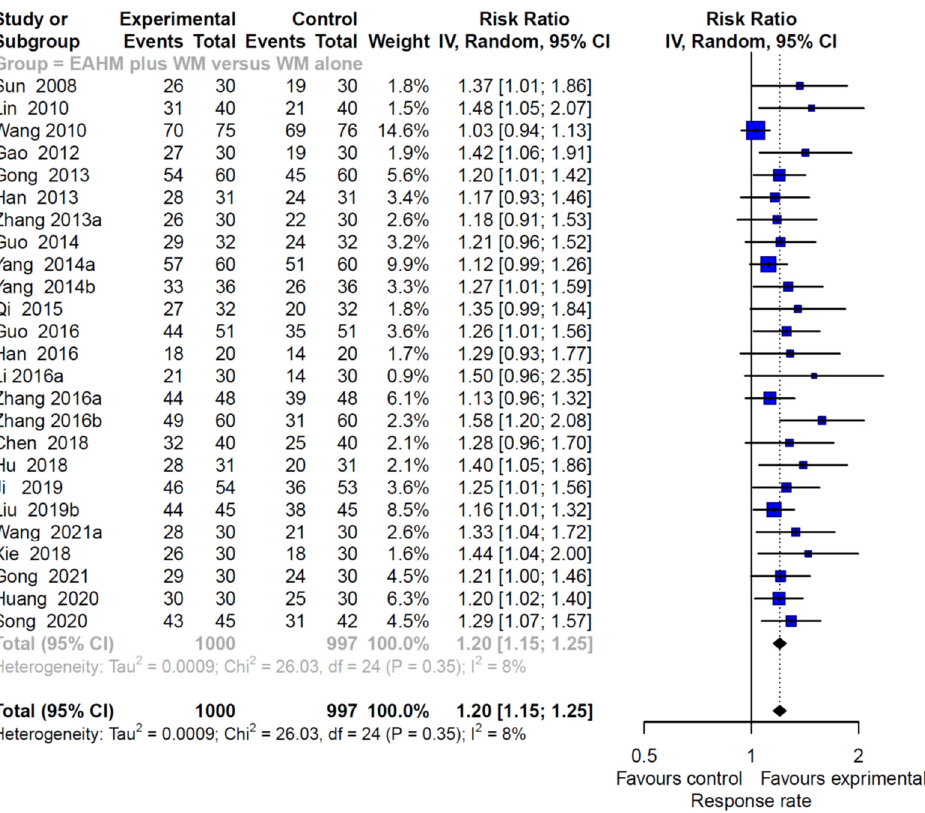
Figure 7. Forest plot of the trials reporting the effect of East Asian herbal medicine monotherapy on the response rate for peripheral neuropathy.